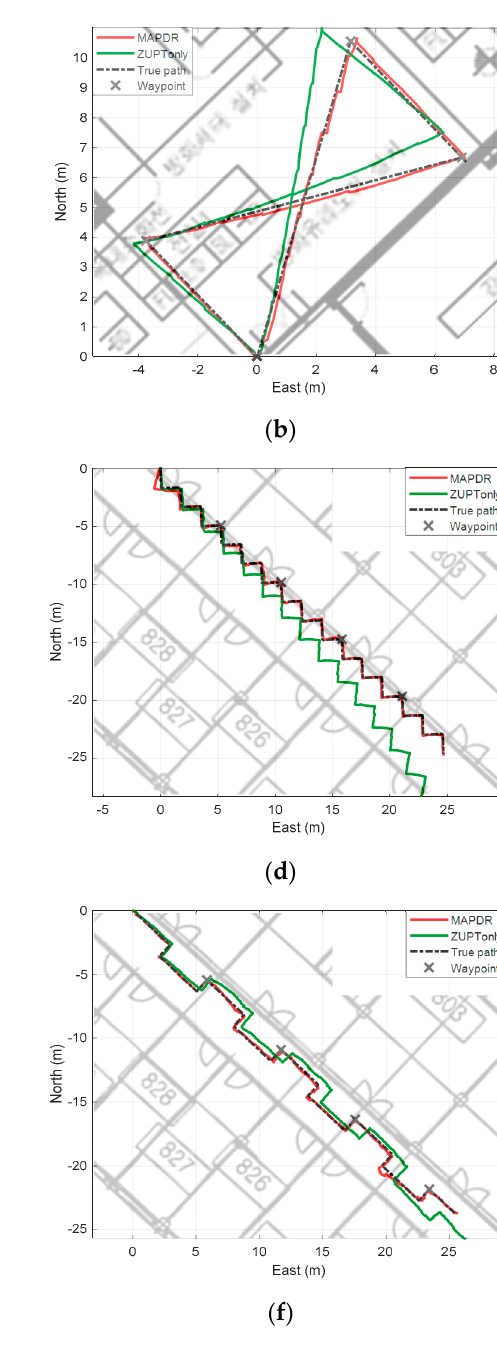
case 5 ( f ) case 6. ( e )